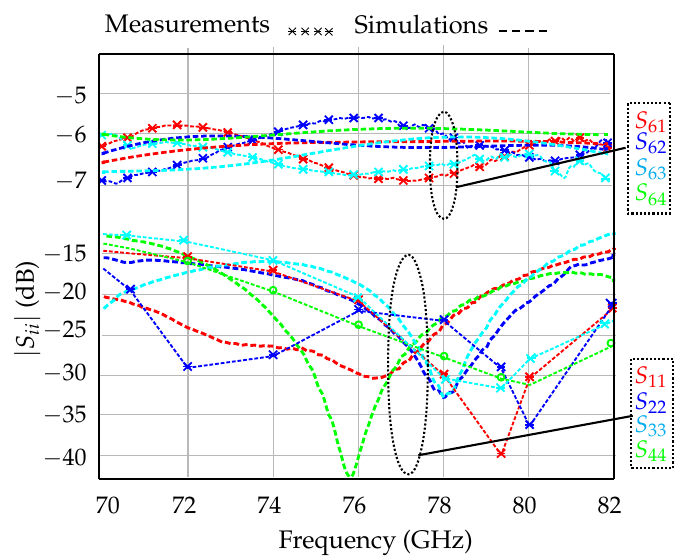
Figure 5. Return losses at the four output ports and the transmission between the RF port ( S 6 i ) and the four output ports.